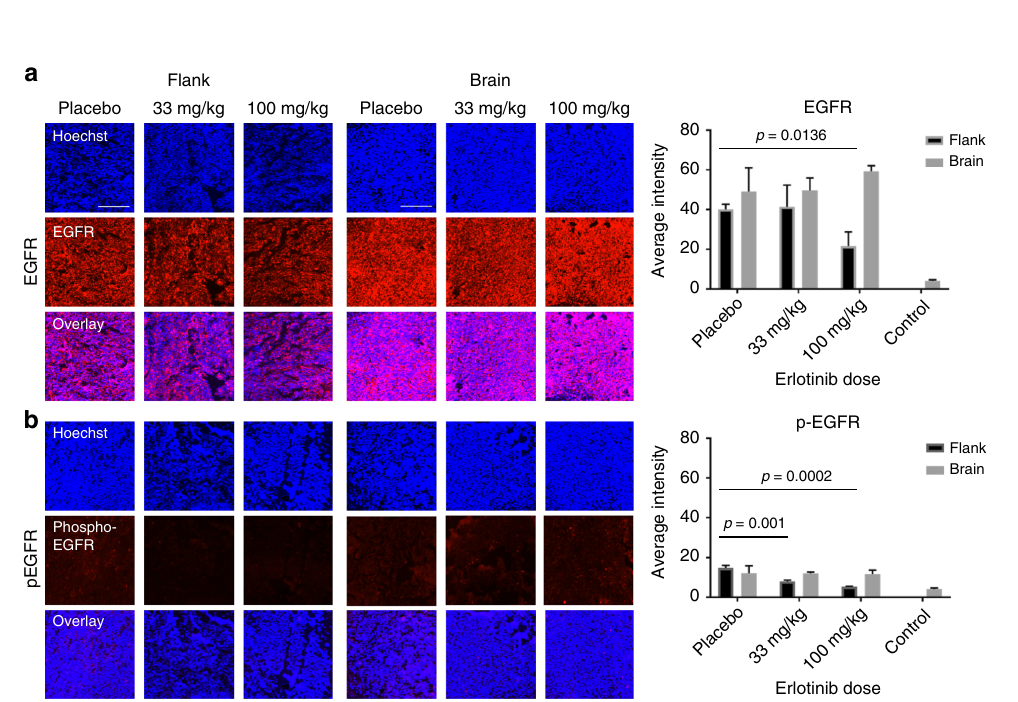
Fig. 4 Tissue Immuno fl uorescence imaging of total EGFR and phosphorylated-EGFR (p-EGFR) in brain and fl ank tumors. a Images showing total EGFR in brain and fl ank tumors (red) overlaid with Hoechst (blue), treated with placebo, low (33 mg kg − 1 ) and high (100 mg kg − 1 ) dose erlotinib, and graphs (on right) showing quantitative analysis EGFR levels over whole tumor region in each treatment group. b Images showing p-EGFR in brain and fl ank tumors (red) overlaid with Hoechst (blue), with placebo, low (33 mg kg − 1 ) and high (100 mg kg − 1 ) dose erlotinib and graphs (on right) showing average (mean) intensity of p- EGFR levels in each treatment group. (scalebars on images represent 250 µ m, error bars represent 1 standard deviation, n = 2 for brain, n = 3 for fl